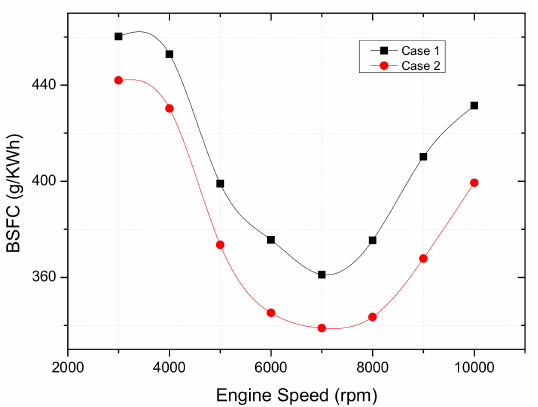
Figure 13. Comparison of engine power between the original and new valve mechanisms.